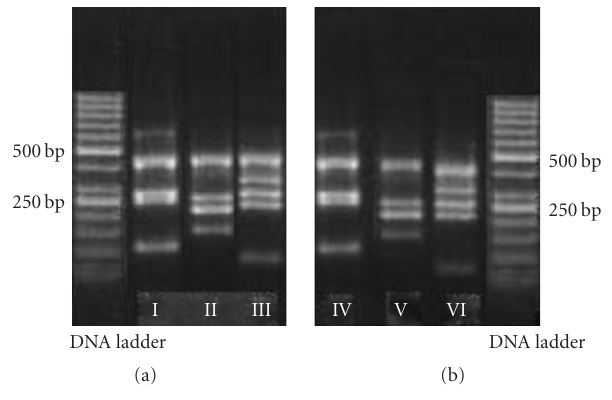
Figure 3: Photos of 3 % high-resolution agarose (mucinous agarose) gel electrophoresis of the three multiplex PCR amplicons from the patient’s DNA (genomic DNA was isolated from buccal mucosa ) and control DNA. Band patterns of the control DNA: I, II, and III, band patterns of the patient’s DNA: IV, V, and